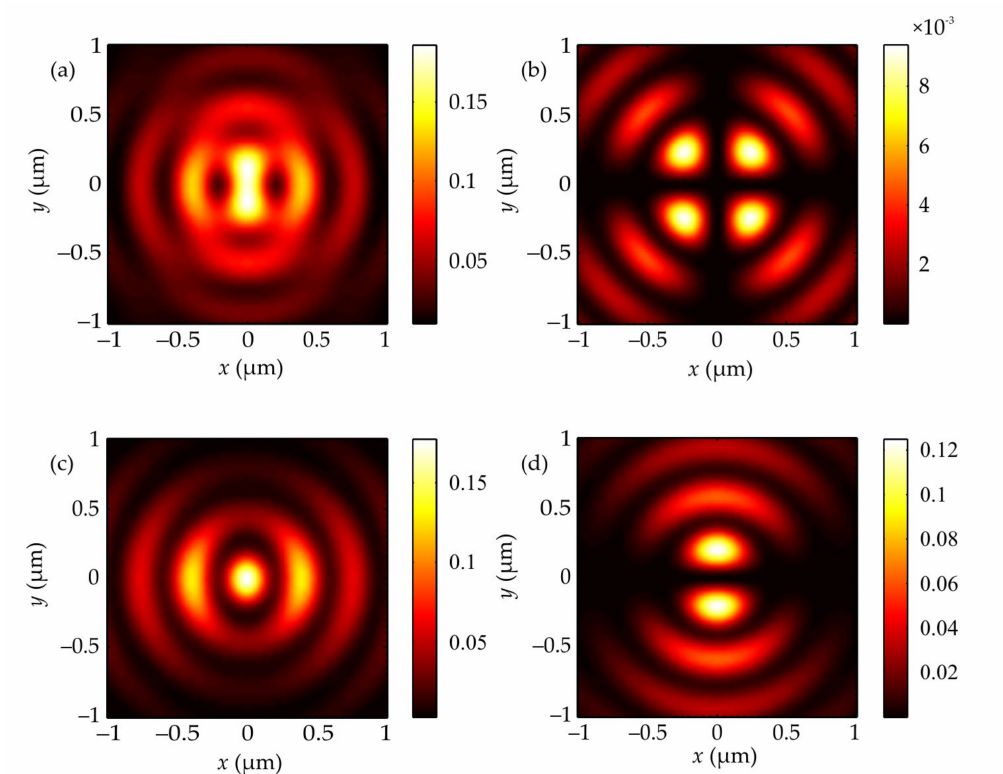
Figure 2. Distribution of the total intensity I x + I y + I z ( a ) and individual components of the intensity I x ( b ), I y ( c ), I z ( d ) at a distance λ after the focus.